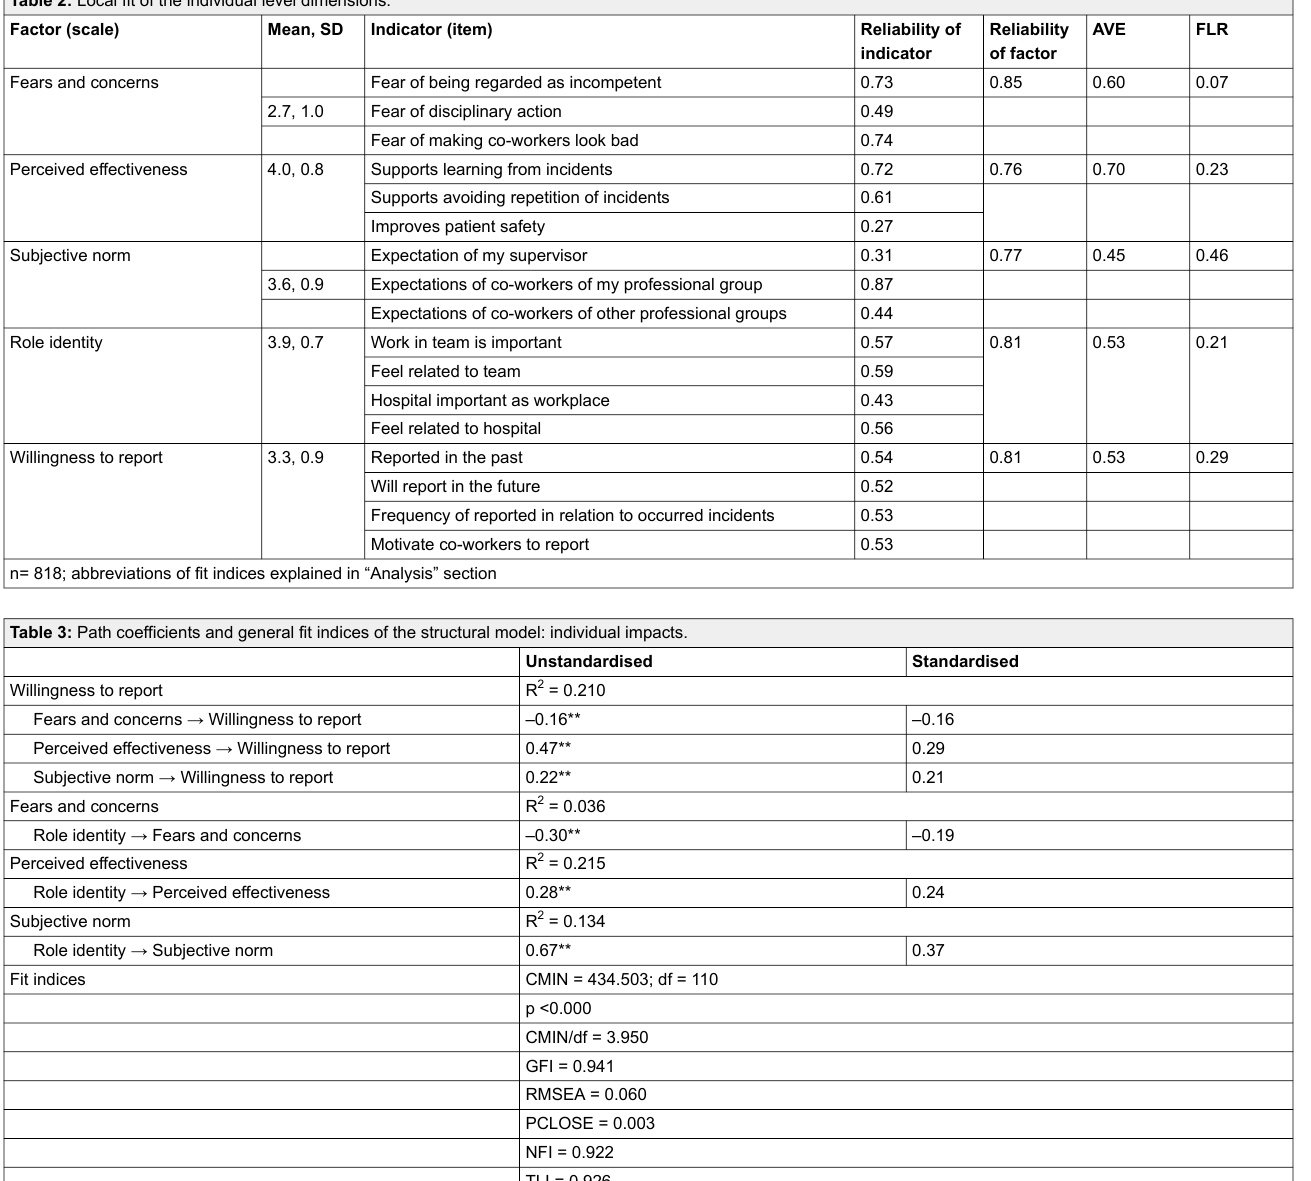
Table 2: Local fit of the individual level dimensions. Factor (scale)